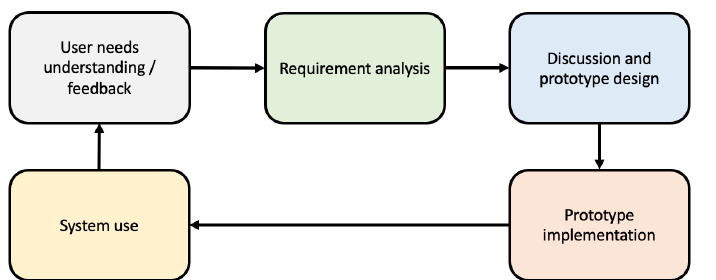
Figure 5. Visual system design procedure. The procedure shows the design and implementation loop to produce our final